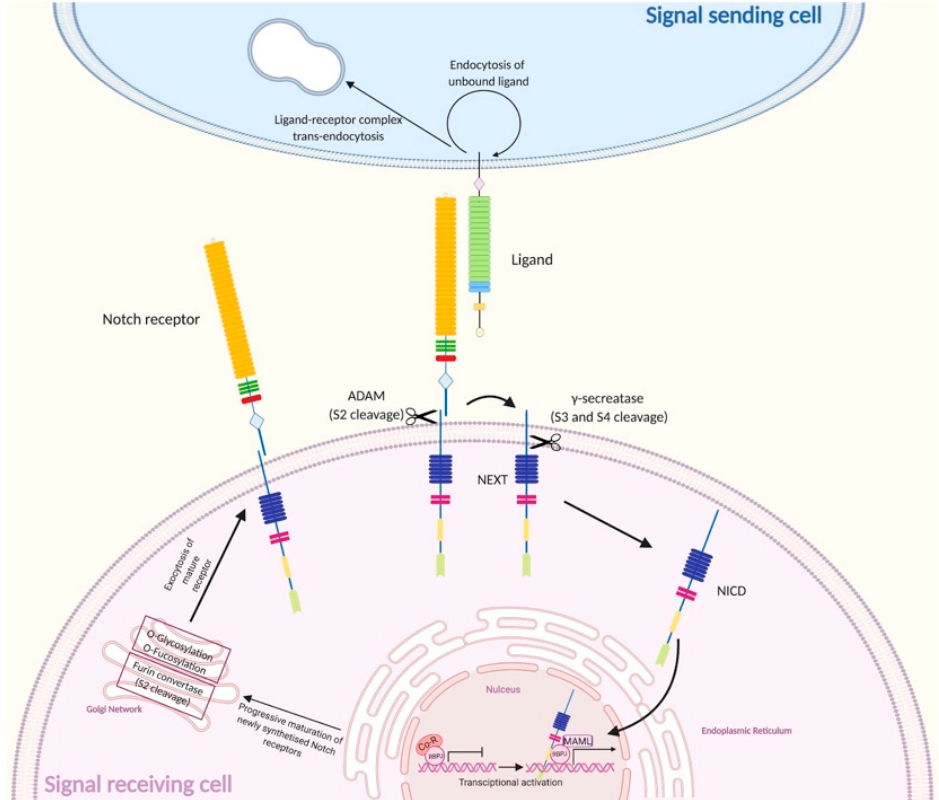
Figure 2. Overview of canonical Notch signaling. Notch receptors are newly translated within the endoplasmic reticulum, processed by a furin convertase (S1 cleavage) and subjected to O-linked and N-linked glycosylations in the Golgi compartment. Once on the cell surface, the receptor is activated by binding to a ligand on a juxtaposed cell. Following ligand binding, Notch signaling is initiated when the trans-endocytosis of ligand-receptor complexes in the neighboring cell induces a conformational change in the receptors, leading to the exposure of S2, site cleaved by ADAM metalloproteases (S2 cleavage) to generate a membrane-tethered partition of Notch, namely Notch extracellular truncation (NEXT). The cleavage in S2 exposes the S3 and S4, allowing the subsequent proteolytic cleavage in these sites by the γ -secretase complex (S3/S4 cleavage), ultimately leading to the release of an intracellular active fragment, the NICD. The NICD migrates in the nucleus and binds to CBF1/RBP-J κ /Su(H)/Lag-1 (CSL), known as RBP-J κ in vertebrates, that under basal conditions is known to function as a transcriptional repressor by associating with ubiquitous co-repressor (Co-R) proteins, and to transcriptional activators of the Mastermind-like (MAML) family, generating the ternary Notch transcription complex that initiates the transcription of downstream target genes. Membrane trafficking and endocytosis is crucial to regulate the availability of receptors and ligands on the cell surface. In the signal receiving cell, pointed arrows ( → ) define the orderly succession of events ranging from the synthesis and processing of Notch receptor, to its activation on the plasma membrane and subsequent induction of the transcriptional machinery. In the signal sending cell, the → the trans endocytosis of the ligand-receptor complex, while the rounded arrow ( ) describes the endocytosis of the unbound ligand.